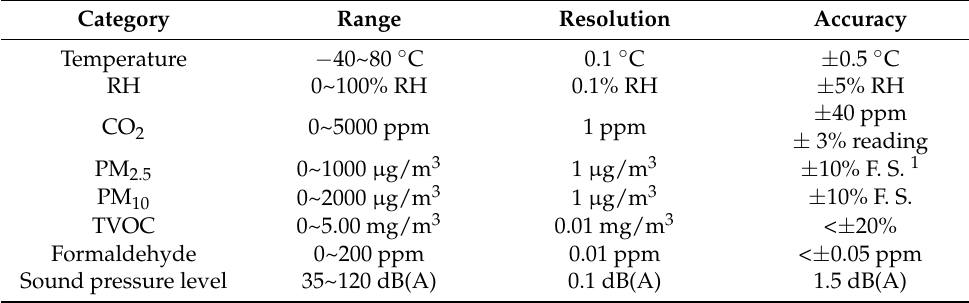
Table 1. Specifications of the environmental monitoring